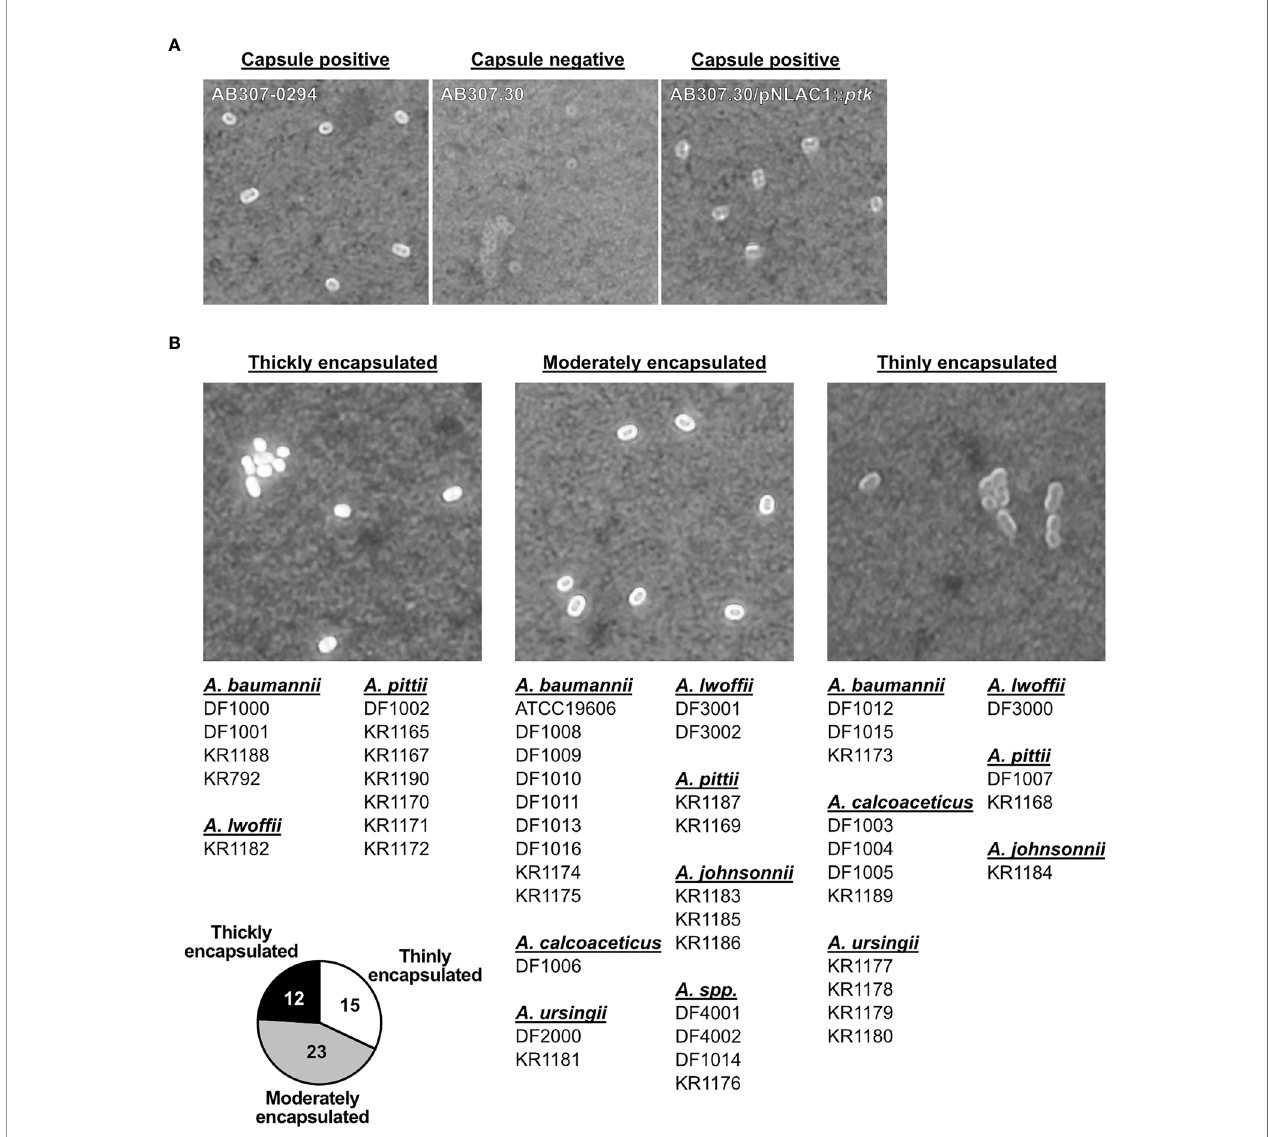
FIGURE 5 | Detection of capsule on Acinetobacter isolates. (A) Detection of the capsule on A. baumannii wt and capsule mutant strains, and (B) Acinetobacter spp. isolates, using India ink and crystal violet staining. Bright fi eld microscopy of bacterial cell with capsule (white halo surrounding cell). Representative image of each strain is presented. Isolates are grouped into 3 groups (thickly encapsulated, moderately encapsulated, and thinly encapsulated), corresponding to the bacterial encapsulation level. Pie chart represents number of isolates in each